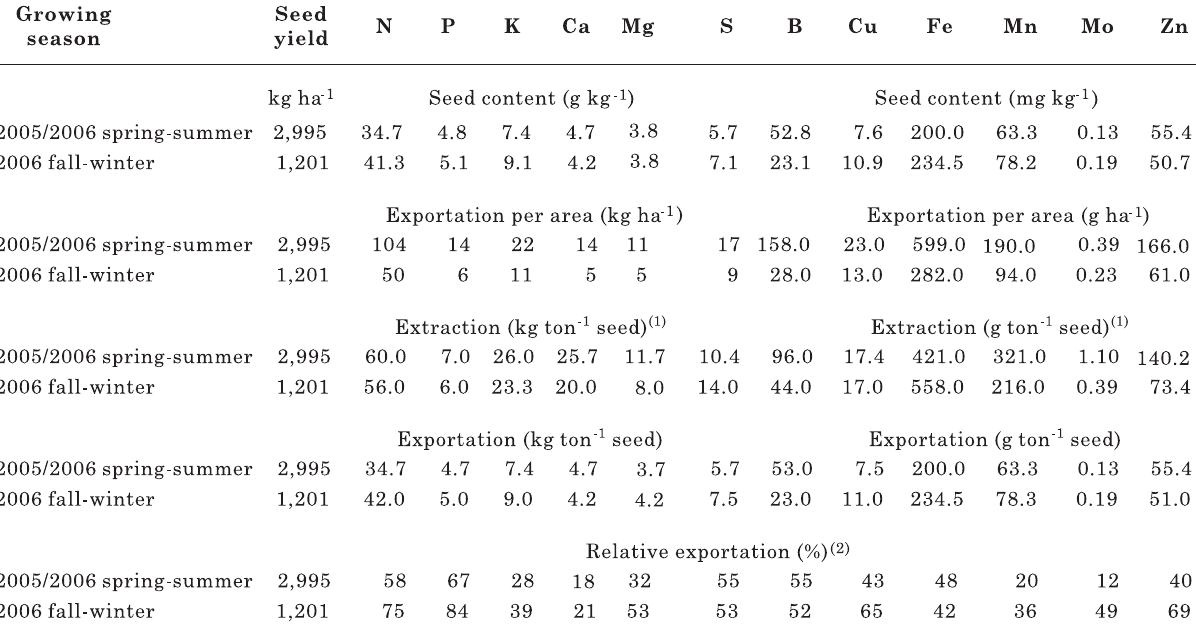
table 1. seed yield, seed nutrient content, nutrient exportation per area, nutrient extraction and expor- tation per ton seed and relative nutrient exportation by castor bean hybrid Lyra in the 2005/2006 spring-summer and 2006 fall-winter growing